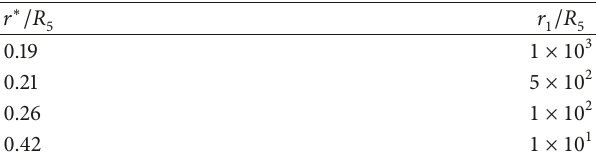
Table 3: Some values of 𝑟 ∗ /𝑅 5 in (25) for different values of the cutoff 𝑟 1 /𝑅 5 . Ideally, we should let 𝑟 1 /𝑅 5 → ∞ for the M5